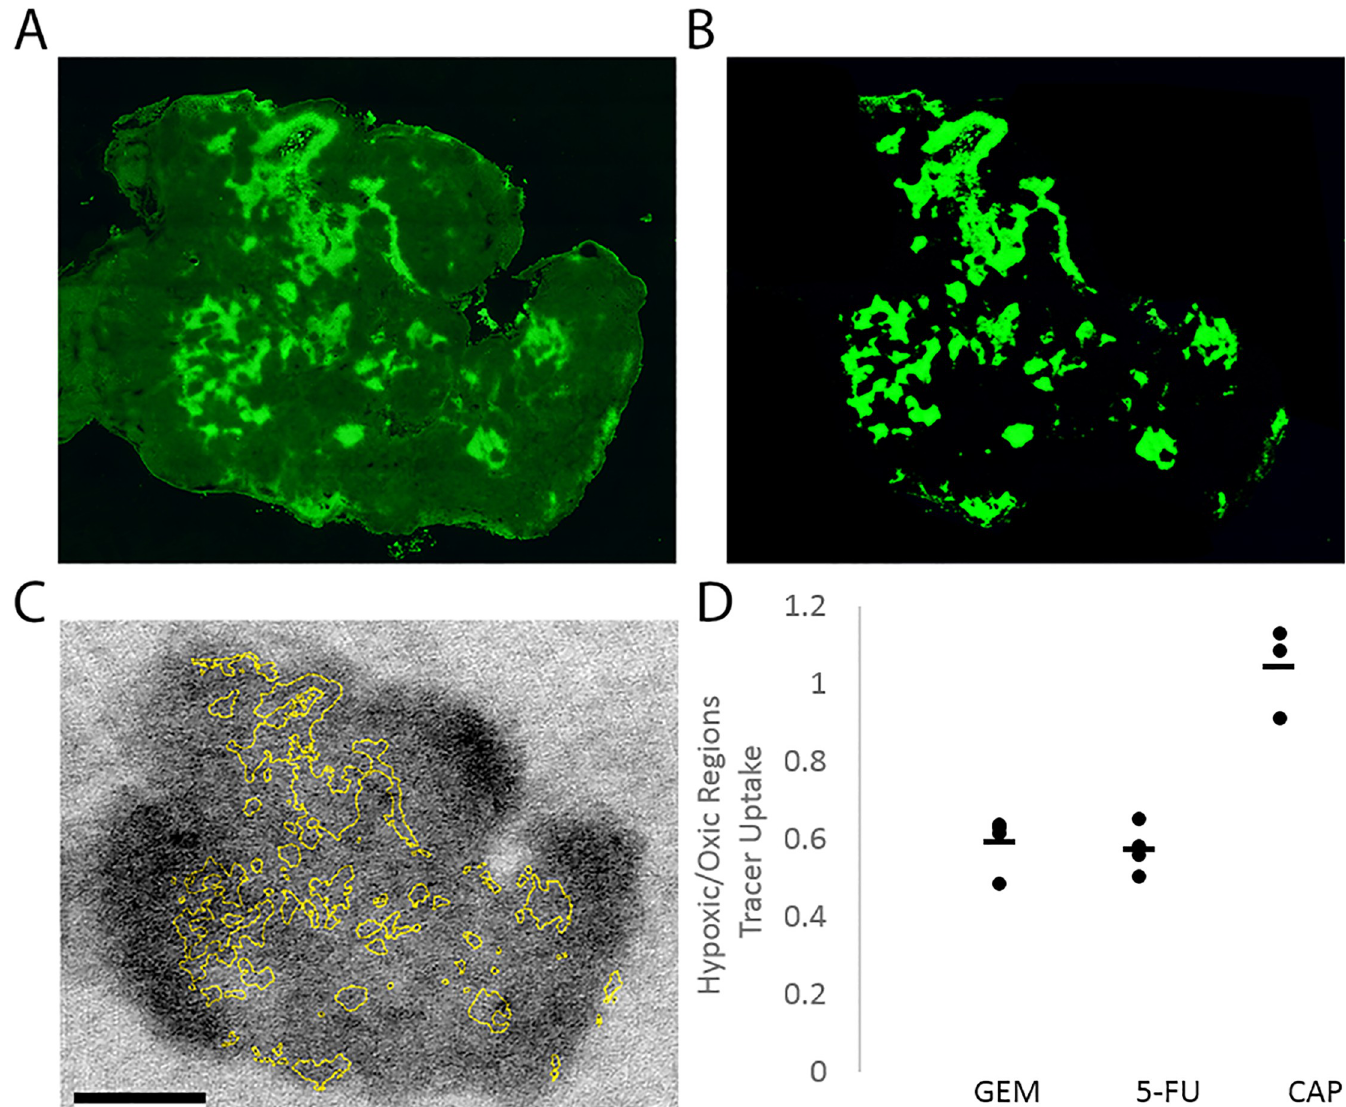
Fig 7. Establishing tracer activity in hypoxic vs oxic regions of the tumor sections. Pimonidazole staining (green) of an organoid tumor section (A). Segmentation of the tumor (green) according to Otsu thresholding (B). The boundaries of the hypoxic regions from (B) are overlaid on top of the 14 C-gemcitabine autoradiography image (C). The ratio of activity in hypoxic relative to normoxic pixels for gemcitabine, 5-FU and capecitabine (D). Dots represent the value for each mouse (n = 3 for gemcitabine, n = 4 for 5-FU and n = 3 for capecitabine). The line represents the mean value. Scale bar is 5 mm.